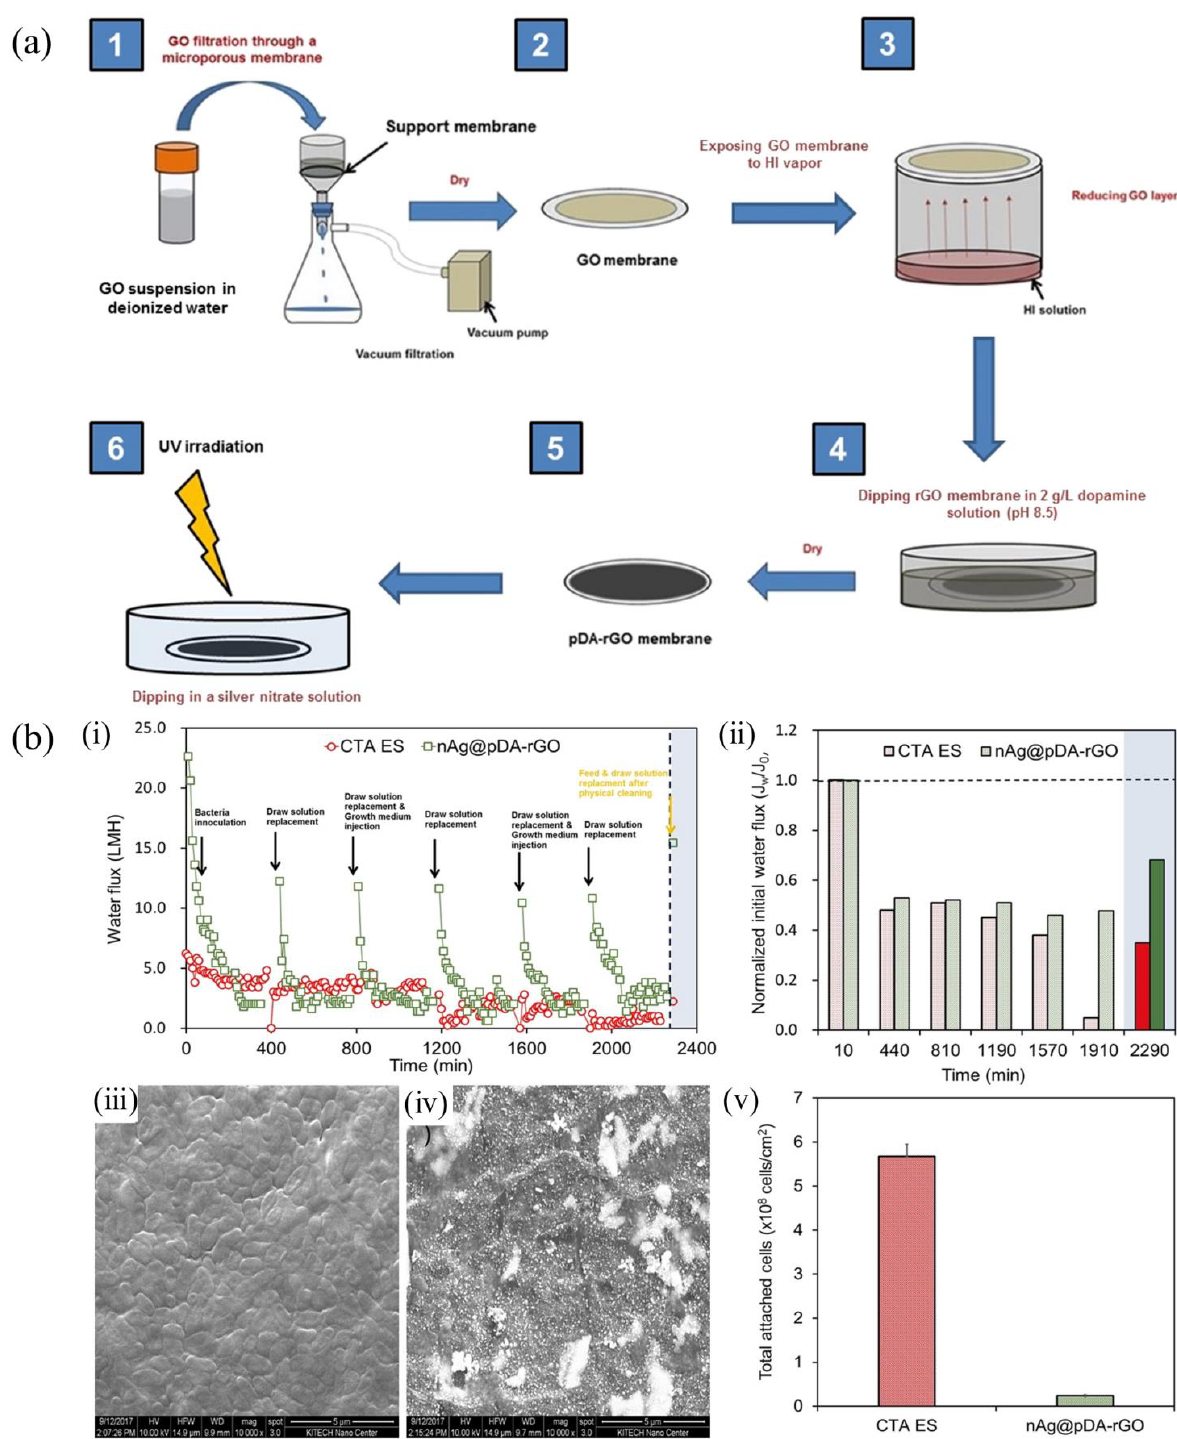
Figure 5. ( a ) Schematic diagram of the fabrication of nAg-pDA-rGO membranes. ( b ) (( i ) Biofouling test in a cross flow FO filtration system showing water flux over time, ( ii ) normalized initial water flux, SEM images of commercial CTA ES ( iii ) and nAg-pDA-rGO membranes ( iv ) after the biofouling test, ( v ) the number of total cells attached on membranes [90]). (Copyright (2018) with permission from Elsevier Ltd.).